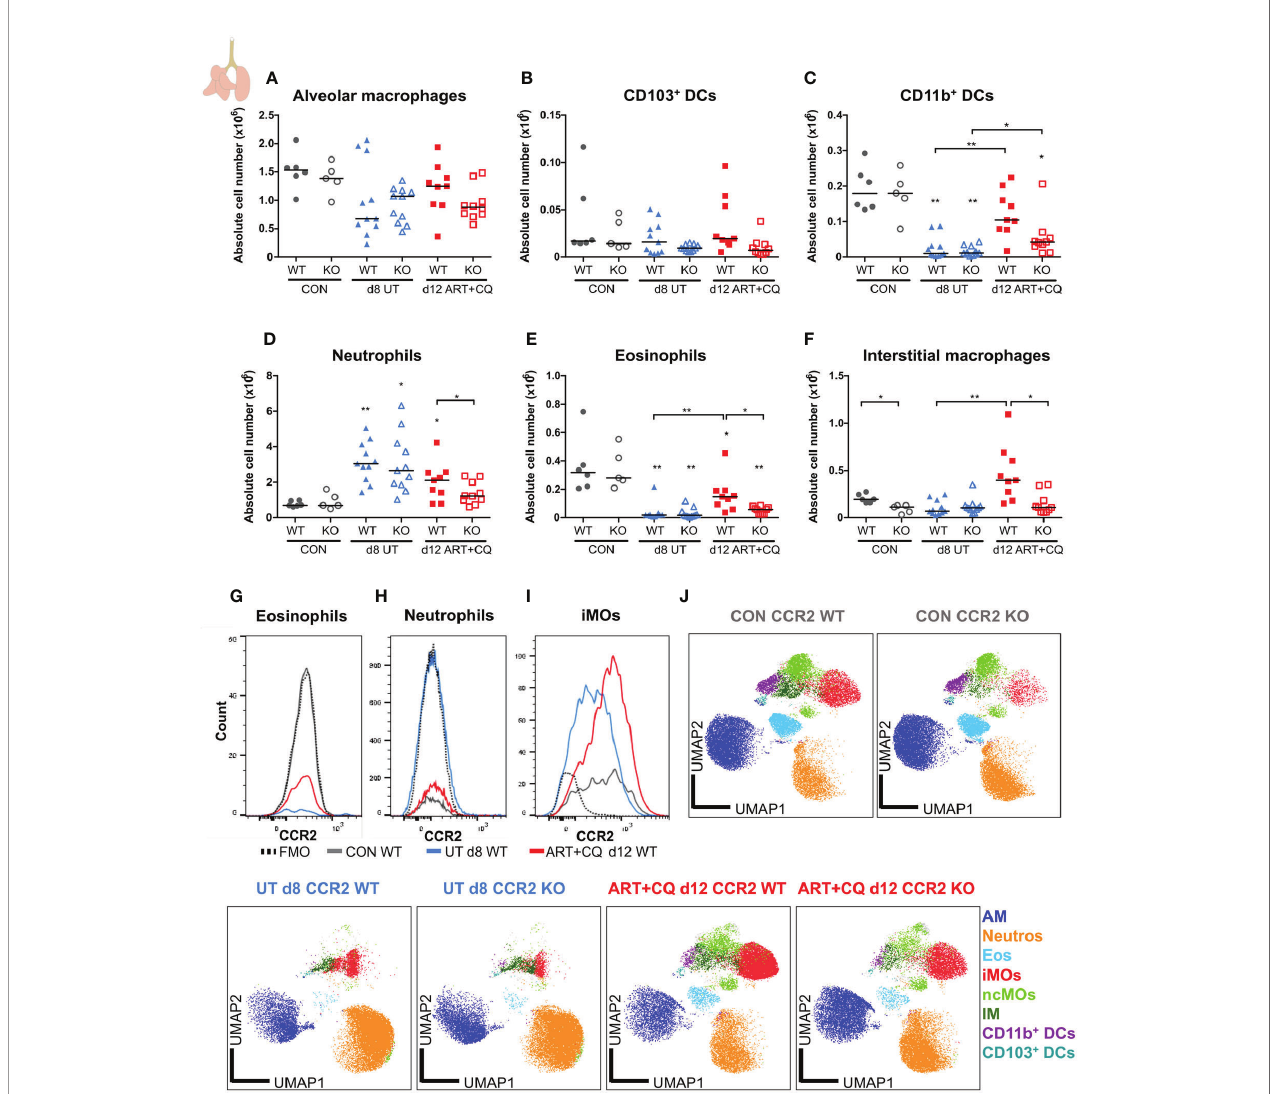
FIGURE 9 | CCR2 is crucial for the return to homeostasis for the myeloid cell populations in the lungs. CCR2 WT and CCR2 KO C57BL/6 mice were infected with Pb NK65. Mice were injected daily from 8 until 12 days p.i. with 10 mg/kg ART + 30 mg/kg CQ. Mice were dissected at the indicated days p.i. Leukocytes were isolated from the lungs according to protocol 2 and fl ow cytometry was performed. (A – F) The absolute numbers of alveolar macrophages (AM; CD45 + SiglecF + CD11b int CD11c + ), CD103 + dendritic cells (CD103 + DCs; CD45 + Lin − SiglecF − MHC-II + CD11c + CD103 + CD11b − ), CD11b + dendritic cells (CD11b + DCs; CD45 + Lin − SiglecF − MHC-II + CD11c + CD103 − CD11b + CD24 + CD64 − ), neutrophils (Neutros; CD45 + Lin − CD11b + Ly6G + ), eosinophils (Eos; CD45 + CD11b + SiglecF + CD11c − ), and interstitial macrophages (IM; CD45 + Lin − CD11b hi MHC-II + CD64 + CD24 − ) in the lungs were calculated. Compilation of two experiments. Each symbol represents data of an individual mouse. n=6 for CON CCR2 WT, n=5 for CON CCR2 KO, n=11 for UT CCR2 WT, n=11 for UT CCR2 KO, n=9 for ART+CQ CCR2 WT, n=10 for ART+CQ CCR2 KO. (G, H) Representative fl ow cytometry plots showing the CCR2 expression of eosinophils (G) , neutrophils (H) , and iMOs (I) in the lungs of CCR2 WT mice at the different time-points. (J) Clustering of 24,000 cells combined from two representative samples per condition for the CON CCR2 WT and CON CCR2 KO and from three representative samples per condition for the others. The plots show a two-dimensional representation (UMAP) of the protein expression. Clusters are colored by cell class as de fi ned in panels (A – F) and Figures 7A, B